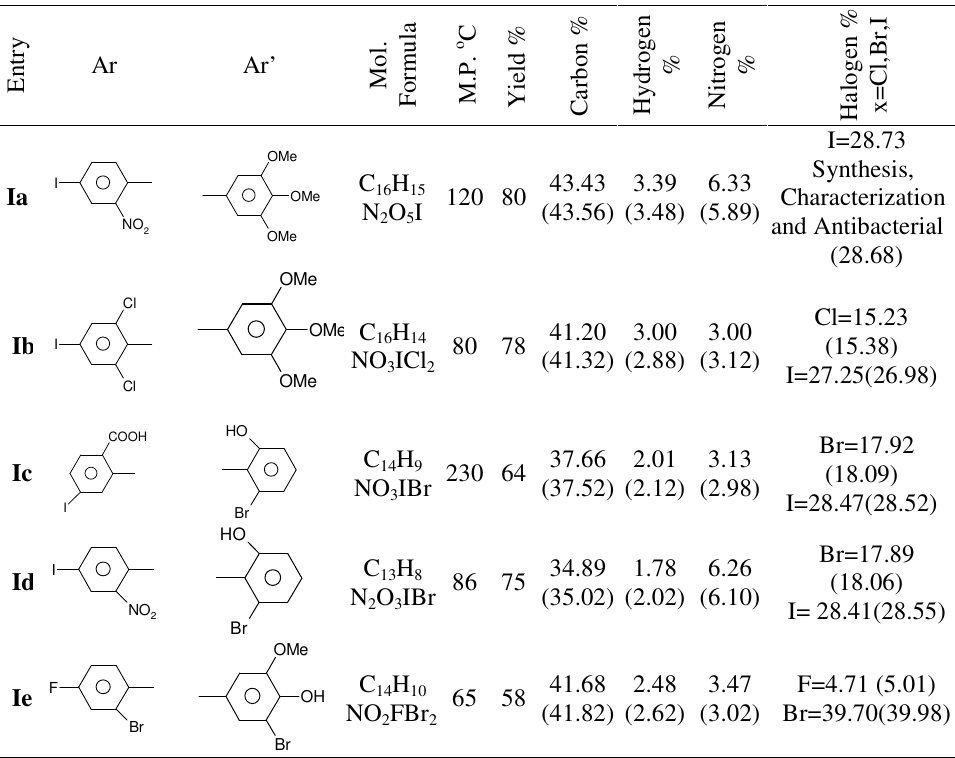
Table 1. Elemental and physical data of halo substituted Schiff